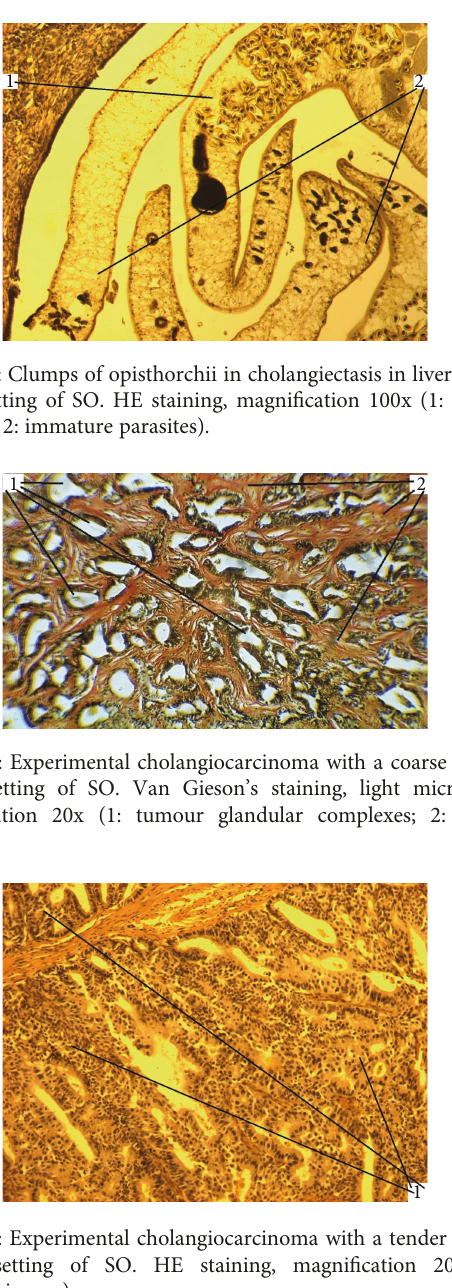
Figure 3: Opisthorchii in a duct located remotely from the tumour (showed by arrow). HE staining, magni fi cation 200x.